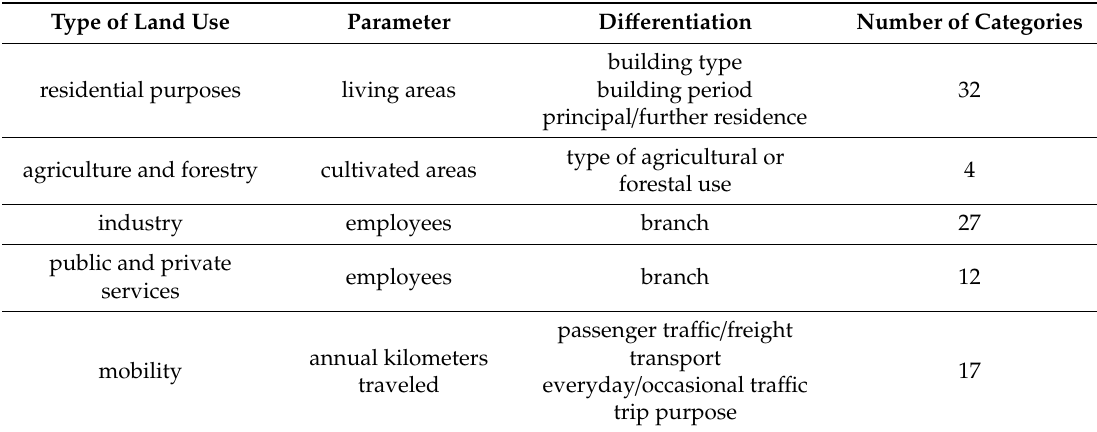
Table 1. The input data to parameterize types of land use and mobility behavior on a local